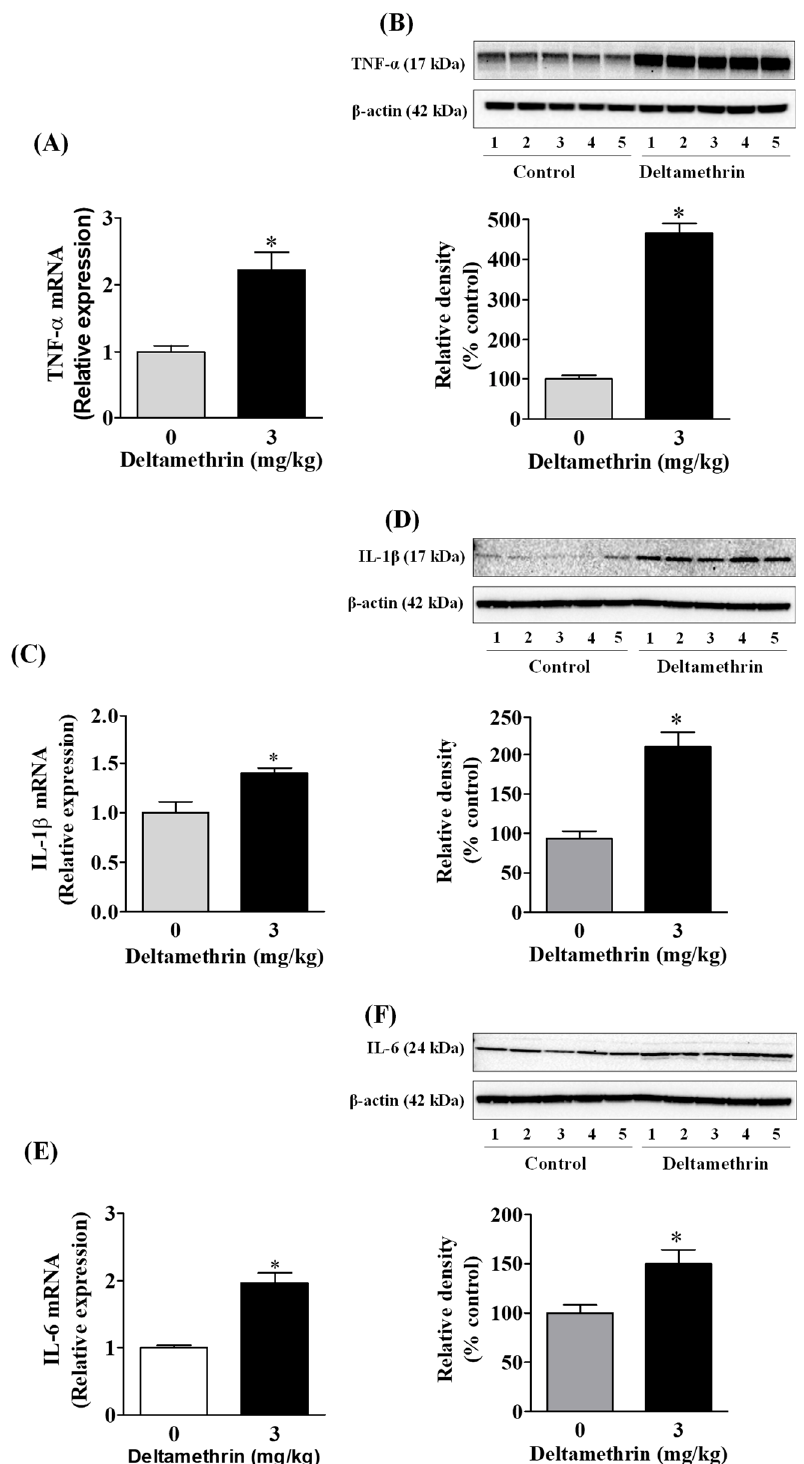
Figure 4. Deltamethrin induces the inflammatory cytokines in the adult mouse hippocampus. ( A ) mRNA and ( B ) protein levels of TNF- α , ( C ) mRNA and ( D ) protein levels of IL-1 β , and ( E ) mRNA and ( F ) protein levels of IL-6. Since the membrane was stripped and re-probed with anti-IL-6 after taking the image of IL-1 β , the same loading control is used for both proteins. The protein bands were quantified by densitometry from Western blot, and the results reported as relative band densities in bar graphs. An asterisk denotes significant difference from control ( p < 0.05).